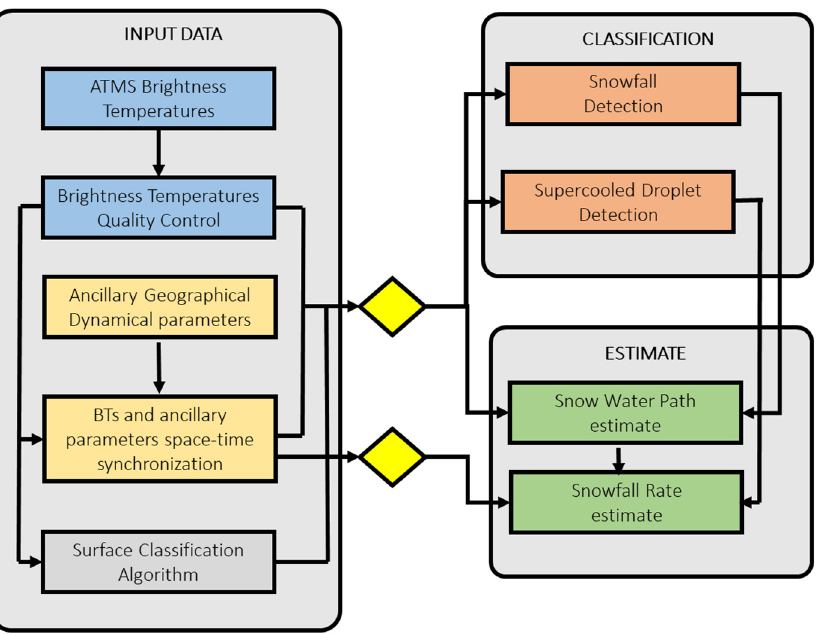
Figure 4. Algorithm flowchart.